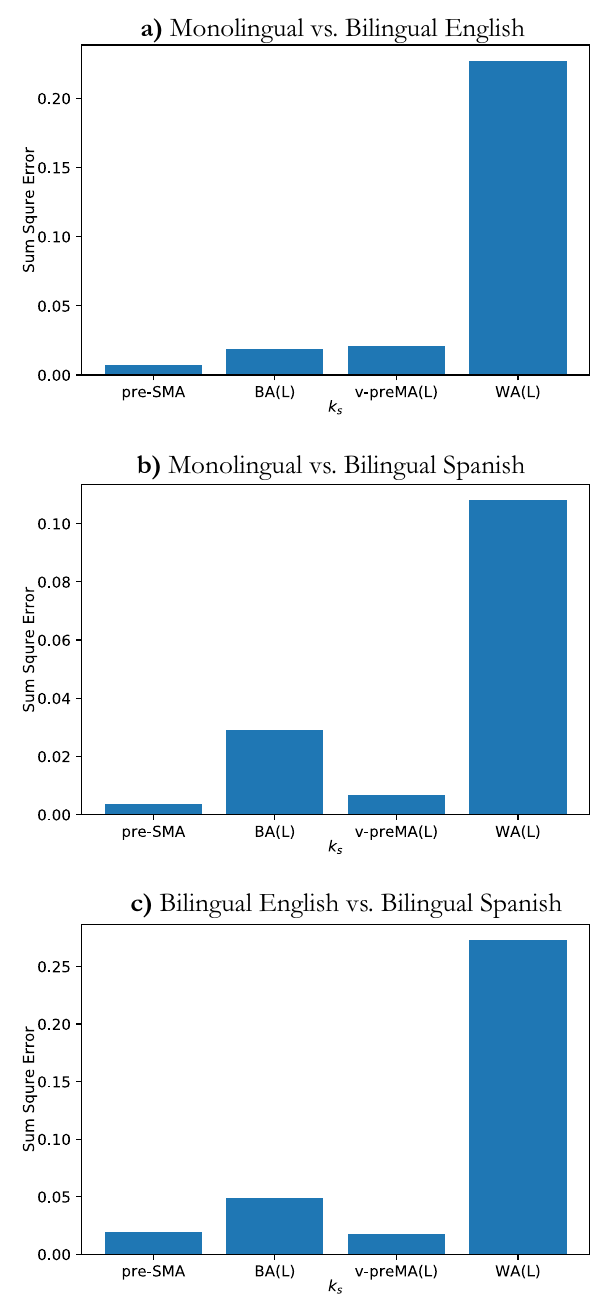
Figure 7. Sum of square errors (SSE) of k -shell occupancy for each module. For all three pair of groups, as shown in ( a ) to ( c ) WA(L) distribution had the largest SSE compared to the “core” modules. Bilingual English and Spanish speakers’ SSE in WA, as seen in ( c ), has the largest value, while monolingual and bilingual Spanish- speakers have the smallest SSE in